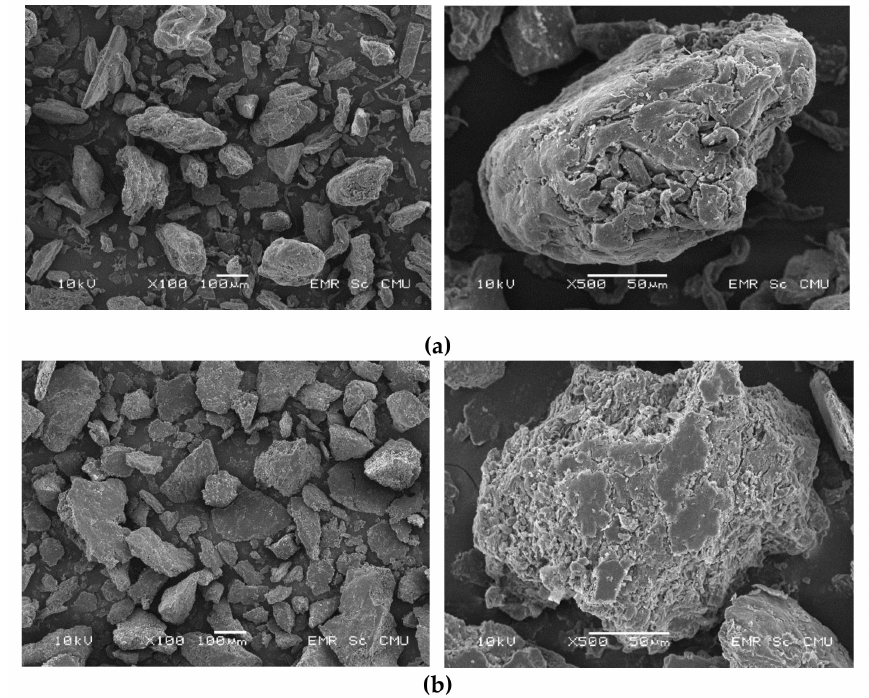
Figure 1. The SEM images of commercial pectin (citrus) ( a ) and pectin obtained using microwave-assisted extraction (MAE) from peel of Nam Dok Mai mango at 700 watts ( b ). The images were viewed at × 100 (left) and × 500